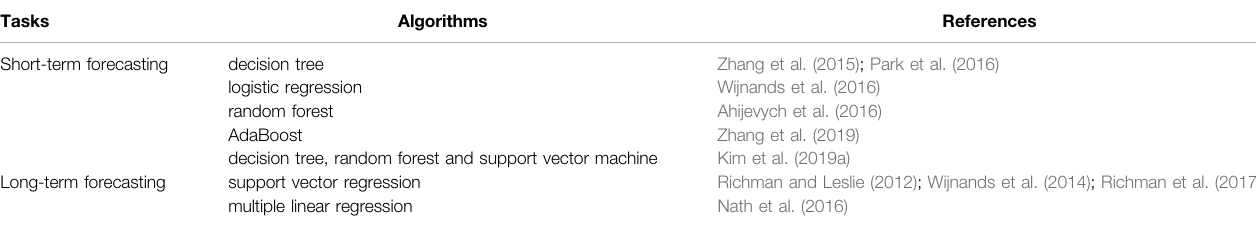
TABLE 1 | Machine learning in TC genesis